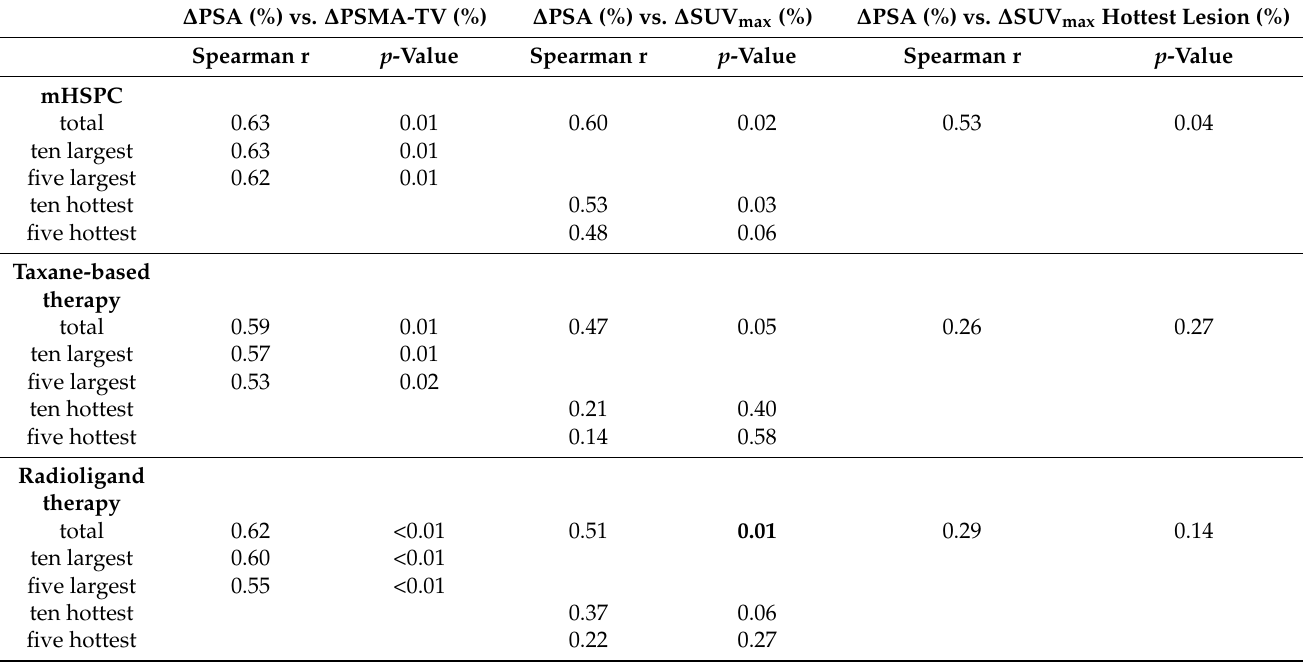
Table 2. Spearman rank correlation coefficients for ∆ SUV max / ∆ PSMA-TV with therapy-induced PSA changes ( ∆